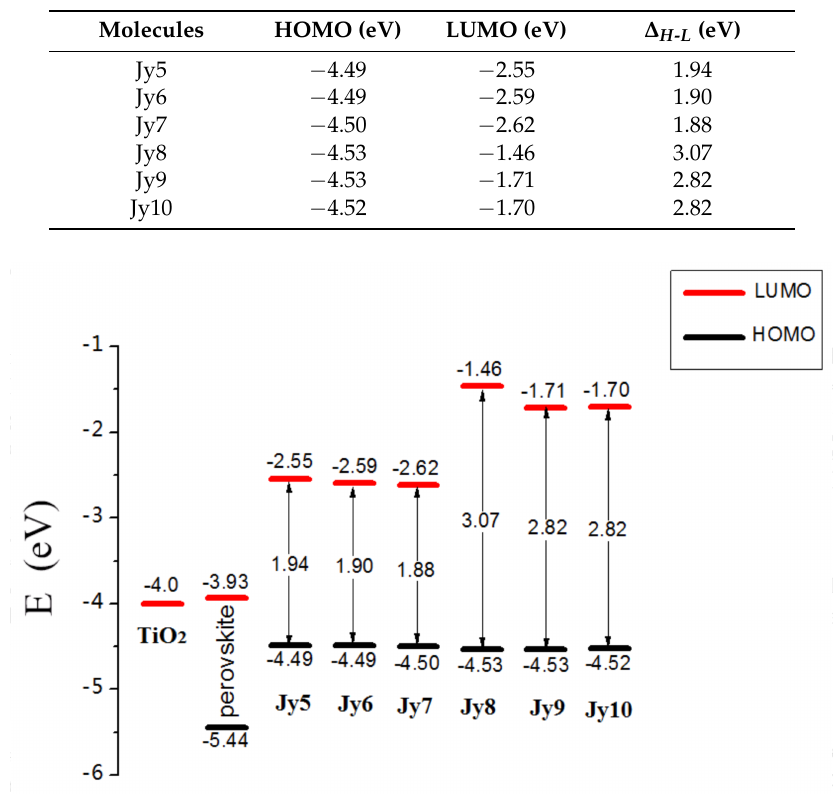
Table 1. Calculated energy levels of frontier molecular orbital (highest occupied molecular orbital (HOMO) and lowest unoccupied molecular orbital (LUMO)), and the energy gaps ∆ H - L of the six studied molecules.